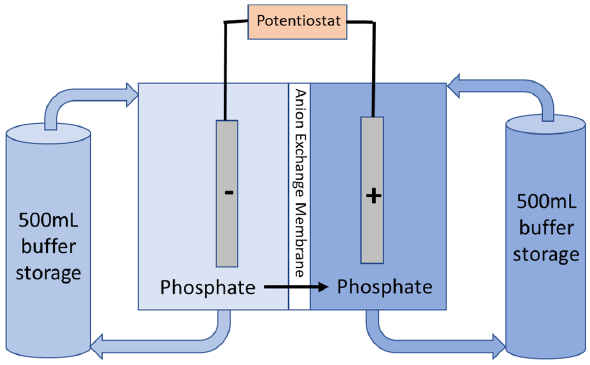
phosphate concentrations in each chamber were measured using HACH kits. The best AEM was determined by the highest phosphate ion transfer.